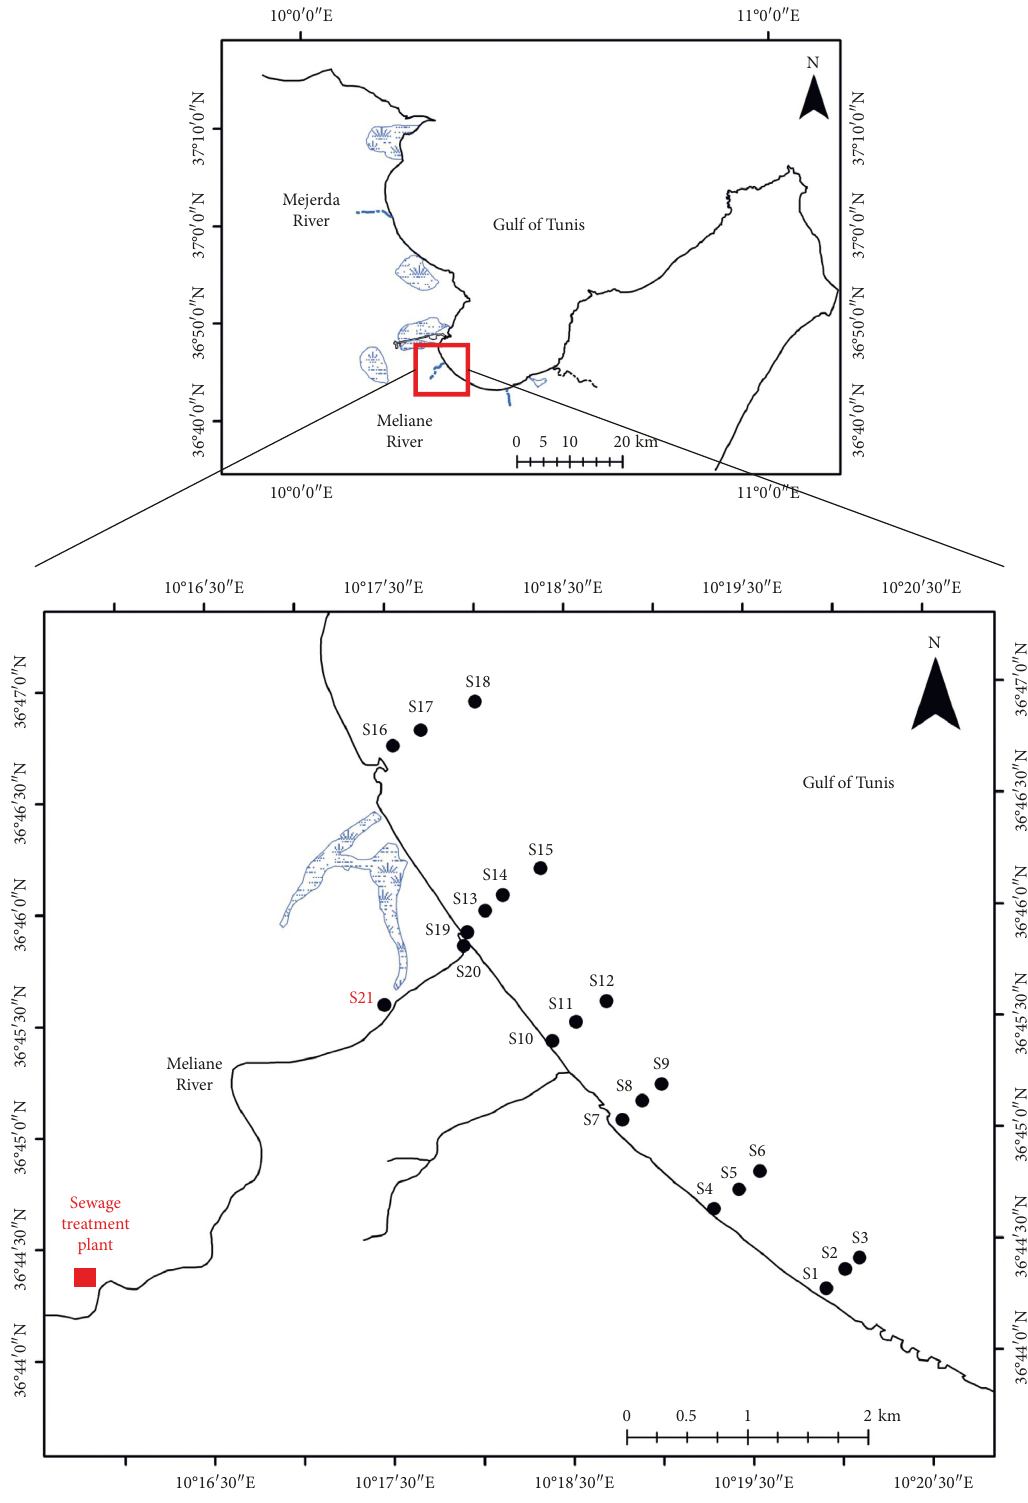
Figure 1: Location map of surface sediment samples along the Rades-Hamam Lif coast around the mouth of the Meliane